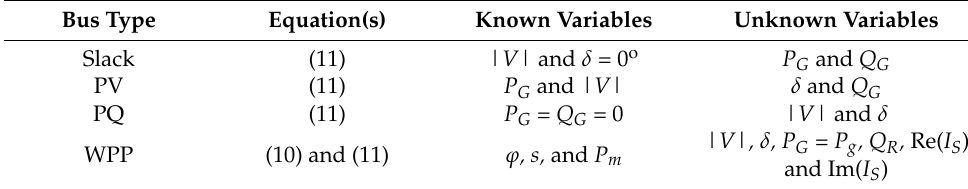
Table 1. Type of buses, equation and quantities.